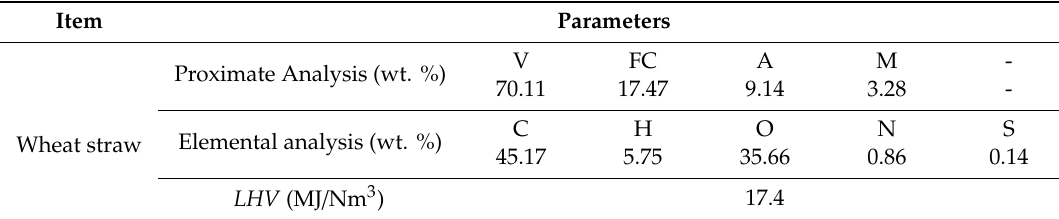
Table 3. Component parameters of